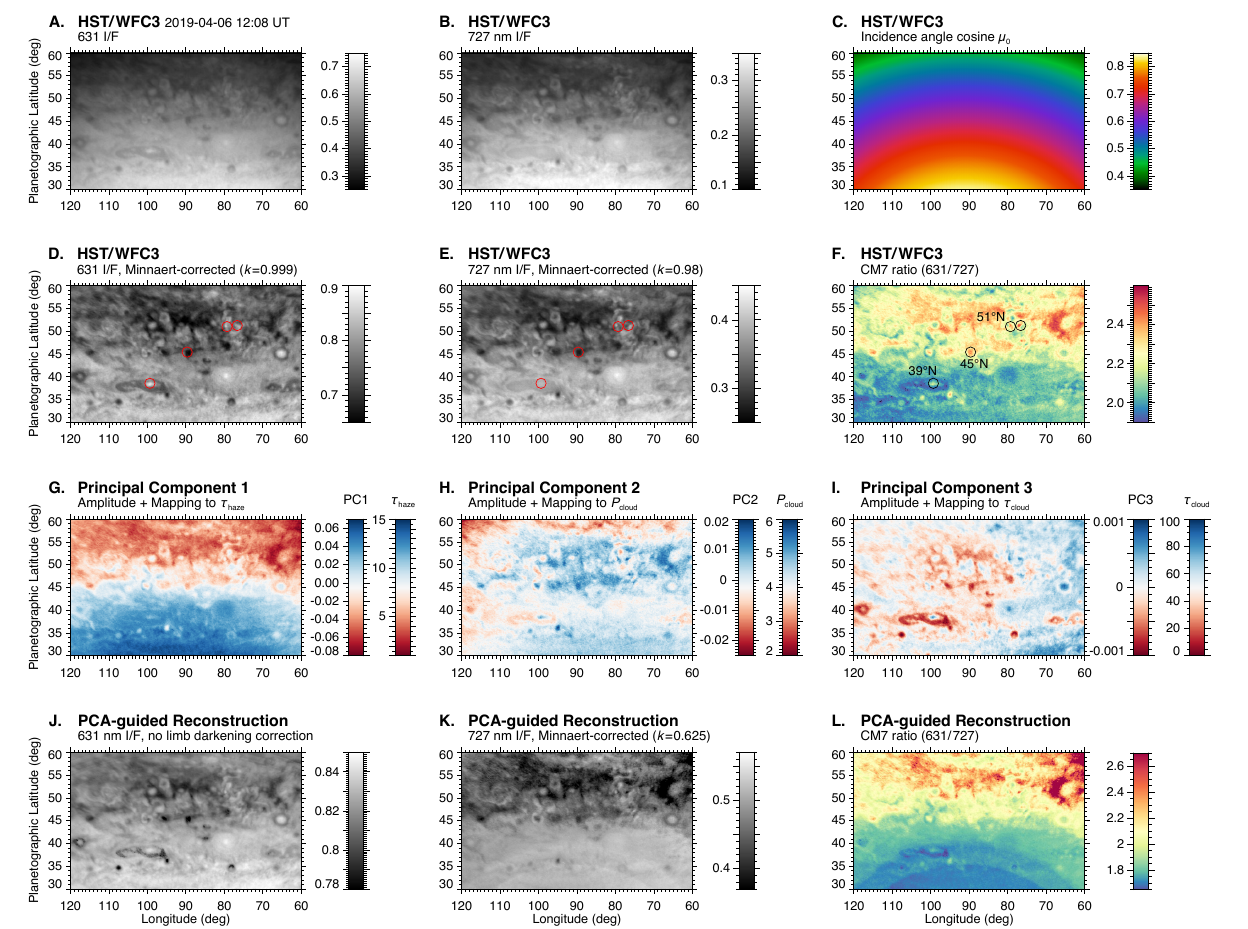
Figure 19. Weak methane band imaging data is sensitive to deep cloud properties, which are highly inhomogeneous on short length scales (at 50 ◦ latitude, 1 ◦ is about 1130 km in the east–west direction and 830 km in the north–south direction). ( A , B ) HST imaging data at continuum and weak methane- band images are shown, overlapping with the areas shown in Figures 2 and 5. Most of the brightness variation in the images is due to limb darkening, a function of the emission angle and ( C ) the solar incidence angle. ( D , E ) With limb darkening corrected, variation due to inhomogeneous cloud properties is clearer. ( F ) The CM7 ratio is calculated from the ratio panels ( A , B ) (i.e., on the data with no limb darkening correction). Several areas with locally high CM7 values are labeled, each with different cloud structure as described in the text. ( G , H , I ) Three orthogonal principal components (PCs) describe the spatial variation in the data. The first colorbar in panels ( G – I ) gives the magnitude of each PC over the spatial domain, and the second colorbar specifies a hypothetical direct mapping of the PCs to cloud structure properties. The cloud property ranges correspond to the ranges modeled in Section 2.3. The SUNBEAR model output was then used to reconstruct the observables as a function of the remapped PCs and the incidence angle at each map pixel. ( J ) The reconstructed 631-nm map is a fair match to the observed data. In particular, the barge is dark, and the fine scale structure is very similar to panel ( D ). The map resembles panel ( D ) more than panel ( A ) in terms of north–south gradient and absolute scale. ( K ) The reconstructed 727-nm map was heavily limb-darkened, so a Minnaert correction was applied in order to show detail in cloud structure. ( L ) The qualitative match with the observed data (panel ( F )) is again good, although some differences can be seen. Importantly, the local maxima from panel ( F ) appear as local maxima in the reconstructed CM7 map, and the values are generally higher (greater deep/upper cloud opacity fraction) north of 45 ◦